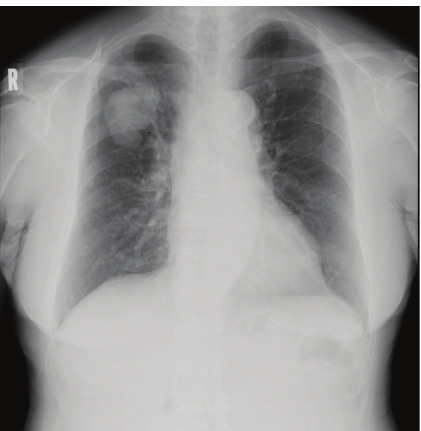
Figure 1: Routine chest X-ray examination shows a large coin lesion in the right upper lung field.